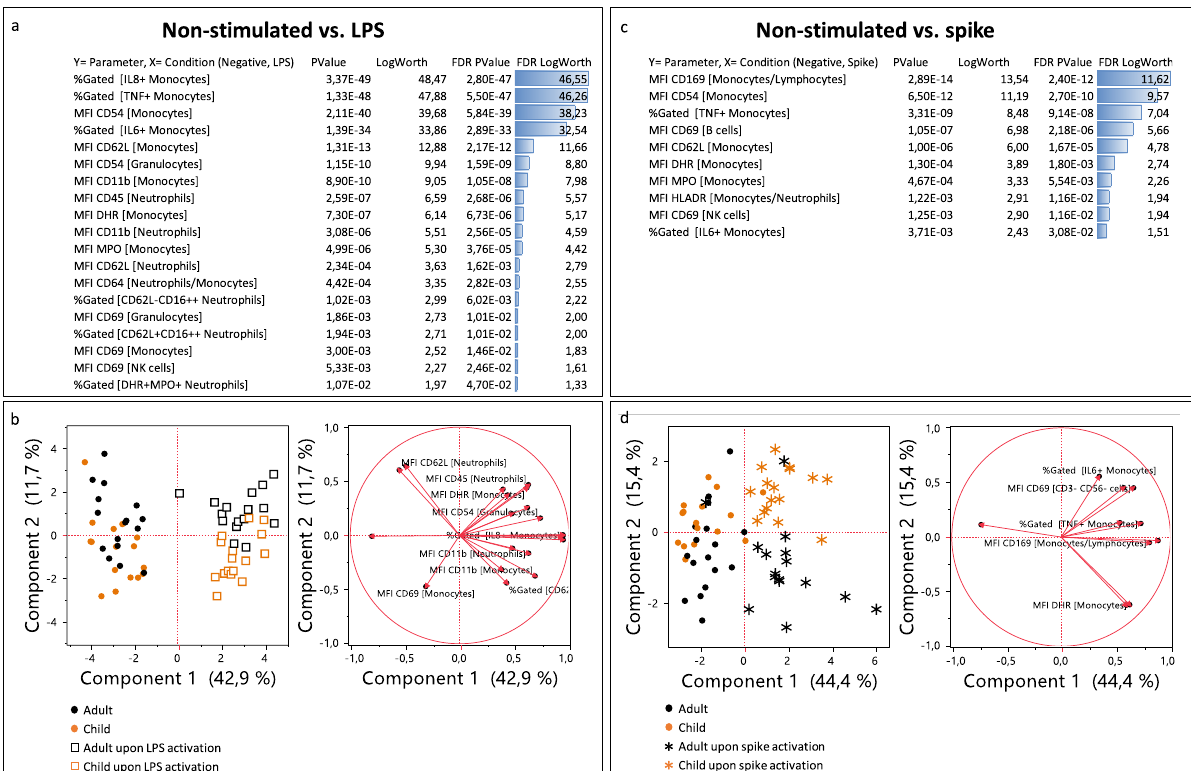
Figure 3. Unsupervised analysis of the biological parameters considered: ( a ) response screen comparing non-stimulated to LPS conditions ( a ) and non-stimulated to trimeric spike conditions ( c ) showing the most discriminant features. ( b , d ) PCA analysis of the best discriminators. Orange color represents children and black adults. Squares illustrate LPS condition and asterisks spike